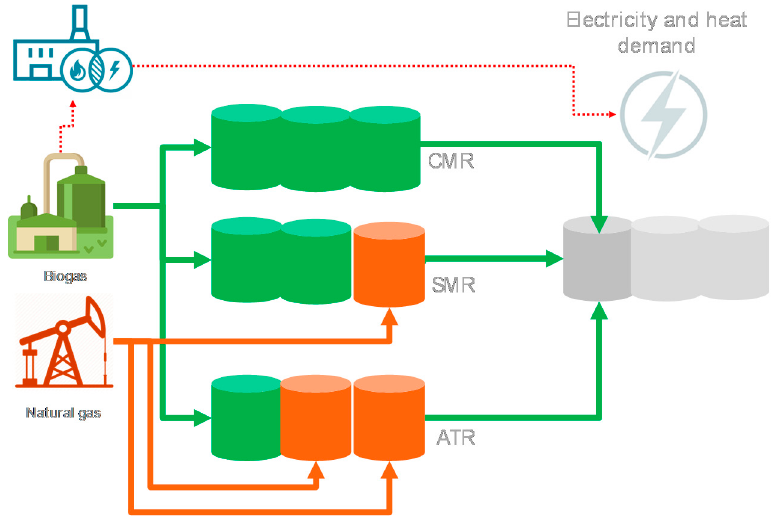
Figure 5. Scenario 1: biogas utilization and H 2 production from the different systems.